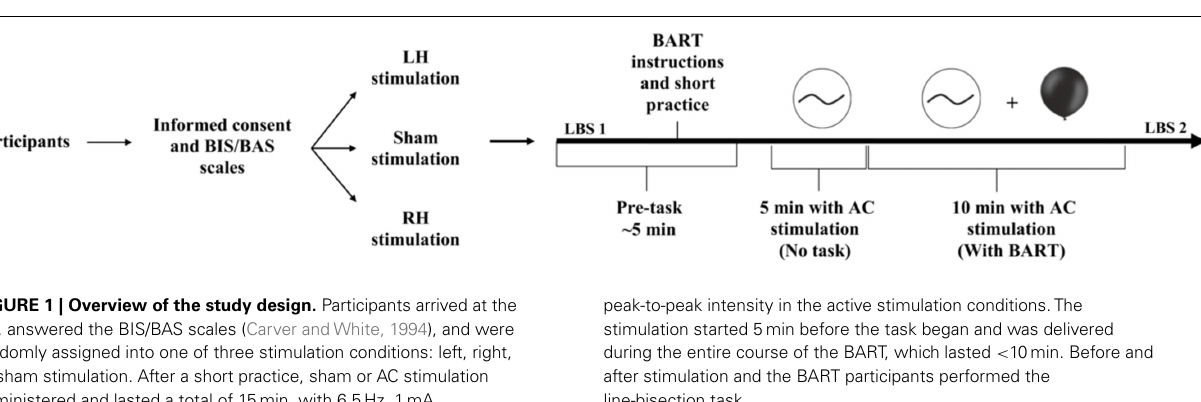
FIGURE 1 | Overview of the study design. Participants arrived at the lab, answered the BIS/BAS scales (Carver andWhite, 1994), and were randomly assigned into one of three stimulation conditions: left, right, or sham stimulation. After a short practice, sham or AC stimulation administered and lasted a total of 15min, with 6.5Hz, 1mA